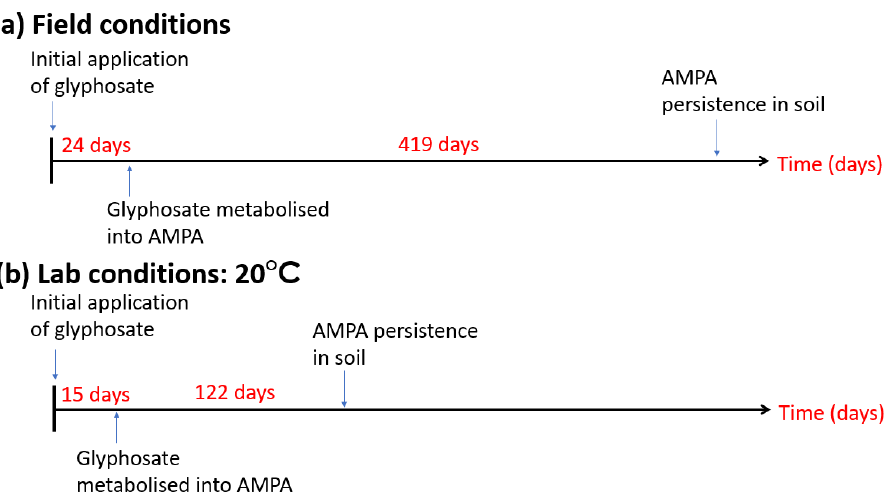
Figure 3. Timeline of glyphosate metabolism and Aminomethylphosphonic acid (AMPA) persistence in soils from both field soils ( a ) and laboratory-controlled soils ( b ), constructed from data provided by the Pesticide Properties DataBase (PPDB) [15,130].